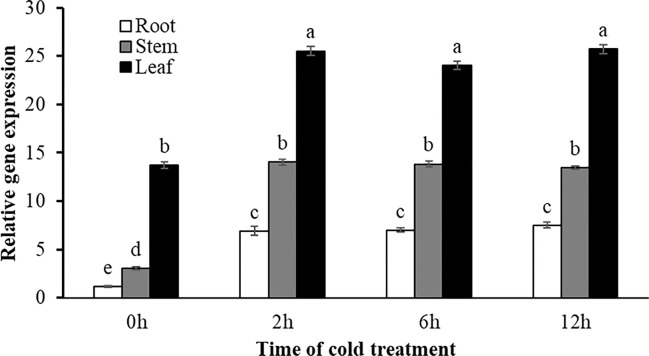
Expression variation of SgRVE6 in stylo root, stem and leaf under normal and cold condition. Root, stem and leaf tissues of stylo seedlings were collected 0 (control), 2, 6, and 12 h after cold treatment and used for qRT-PCR. Relative expression was compared to actin gene and presented as means ± SD of three sample replicates. The same letter above the columns indicated no significant difference at P<0.01 with the corresponding control of each tissue type.